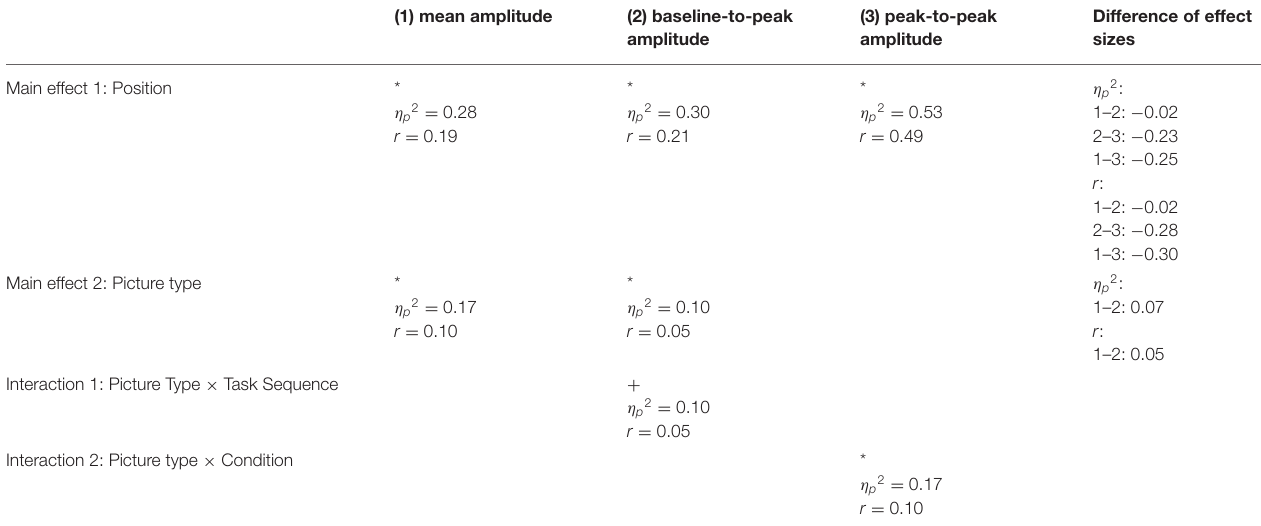
TABLE 3 | Comparison of effect sizes between effects measured with mean, baseline-to-peak and peak-to-peak amplitude.